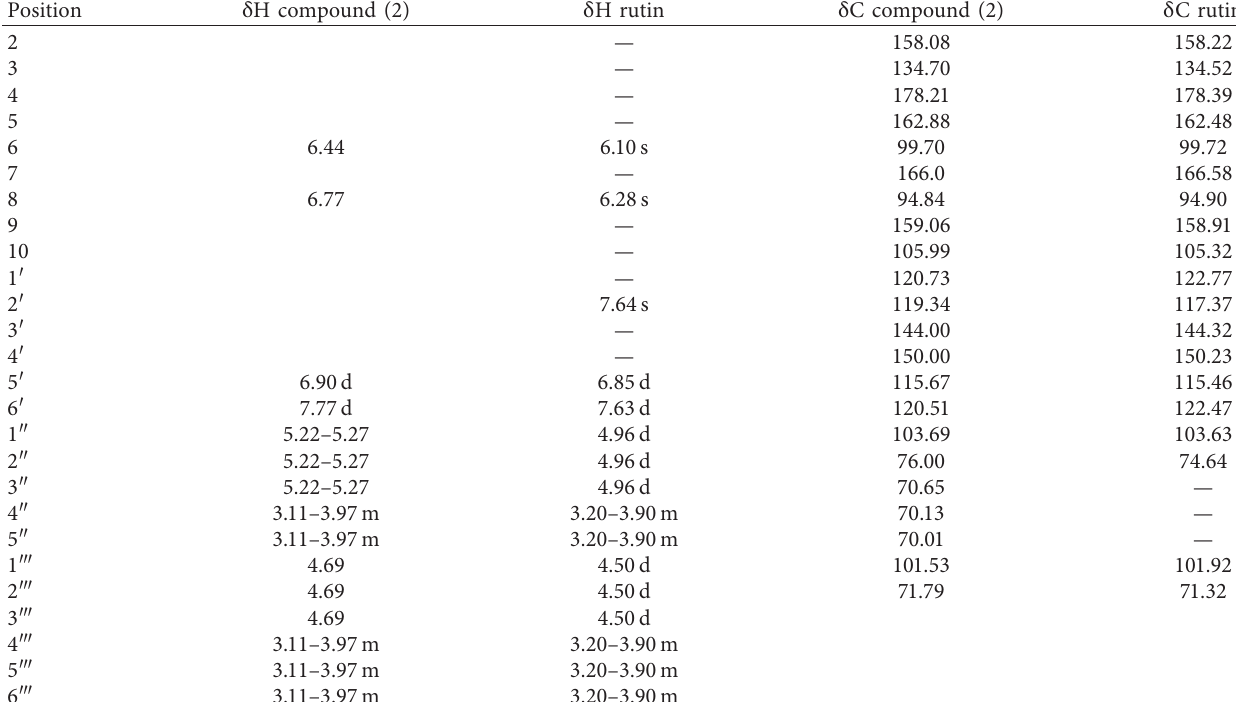
Table 4: 1 H- and 13 C-NMR assignments of compound 2 (700 MHz, DMSO) in comparison with reported data for rutin (quercetin-3- orutinoside) (100MHz, CD3OD) [27].